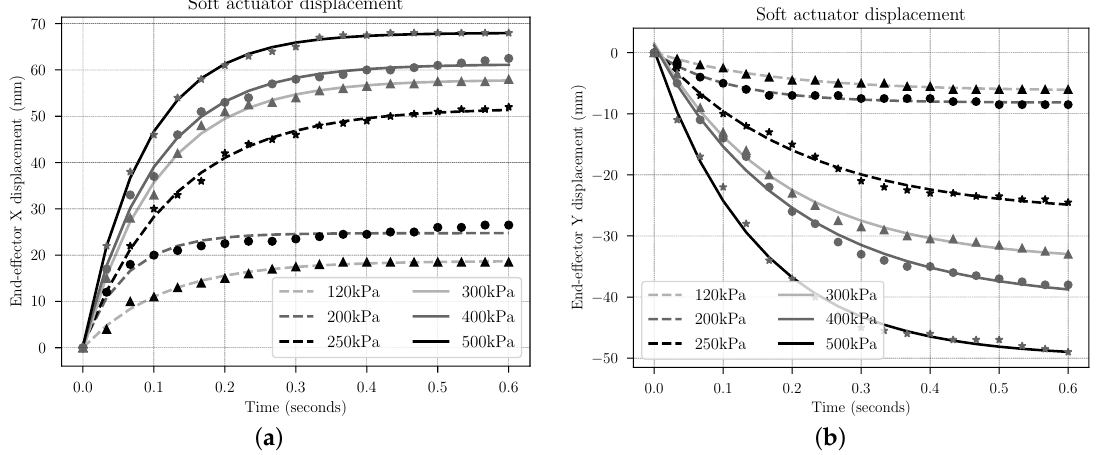
Figure 7. Experimental data of the endpoint of the soft actuator with different internal pressures in the ( a ) x and ( b ) y reference axes of Figure